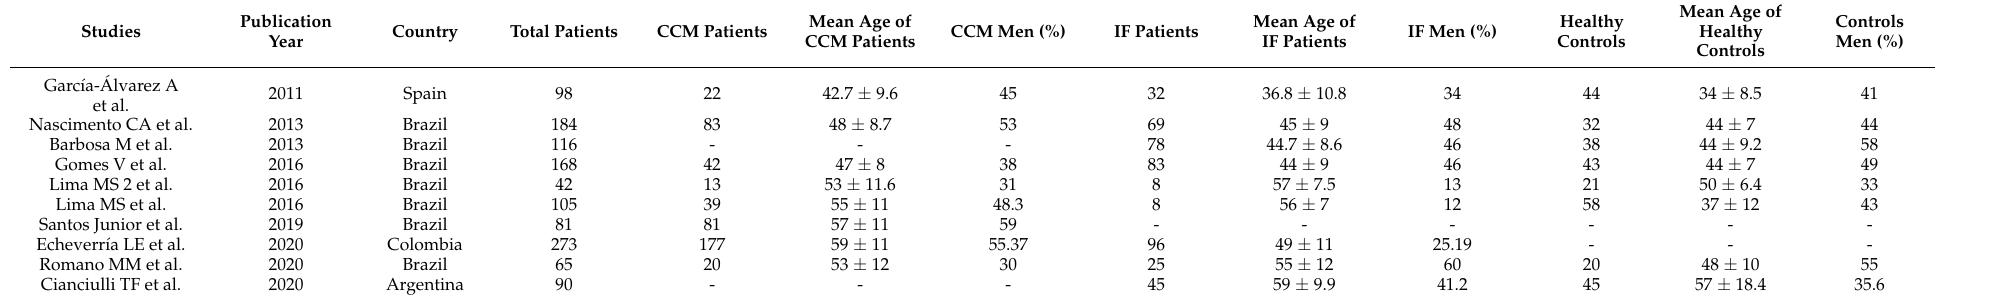
Table 1. Baseline demographic characteristics of patients assessed in the included studies.